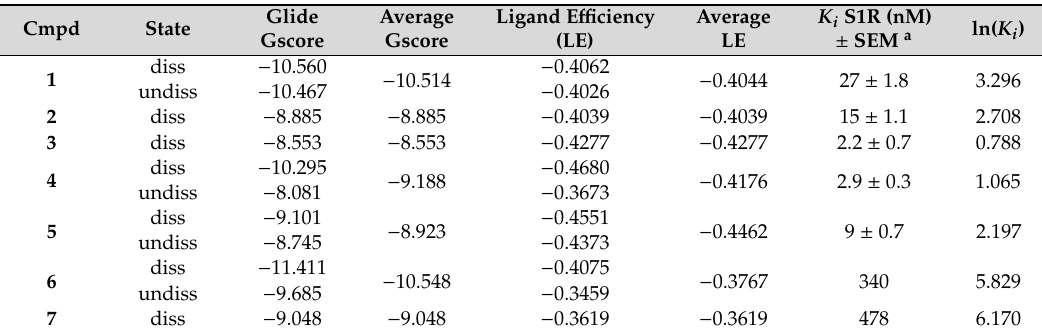
Table 1. Glide Gscores, calculated Ligand Efficiencies and experimentally determined K i values of compounds 1–8 employed for the elaboration of the docking model.